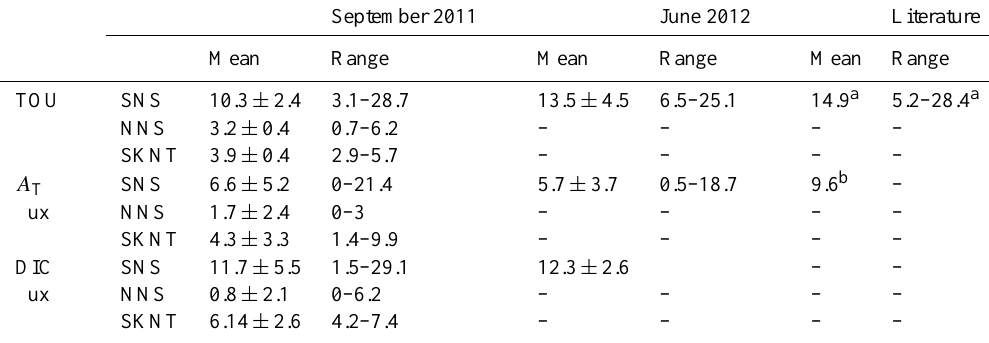
Table 2. Fluxes at the sediment–water interface for O 2 (TOU), A T , and DIC. a Hydes et al. (1999); b Thomas et al. (2009). Units